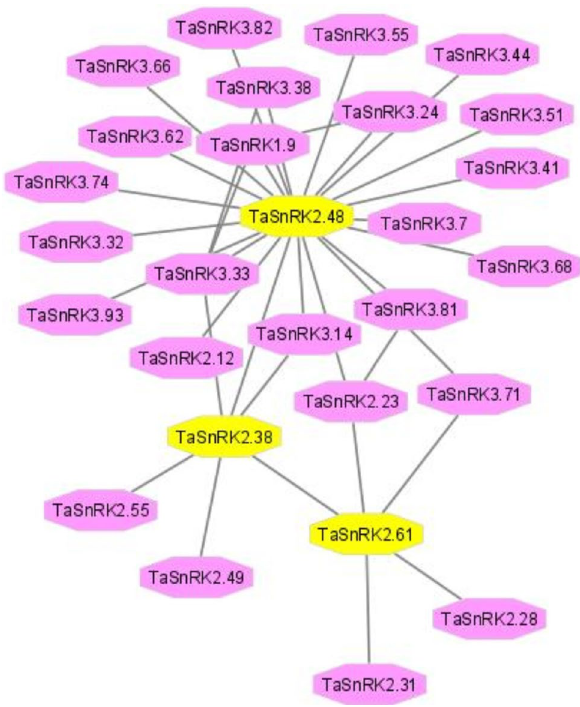
Figure 6. The predicted protein–protein interactions network of SnRK in wheat based on the Arabidopsis orthologs using